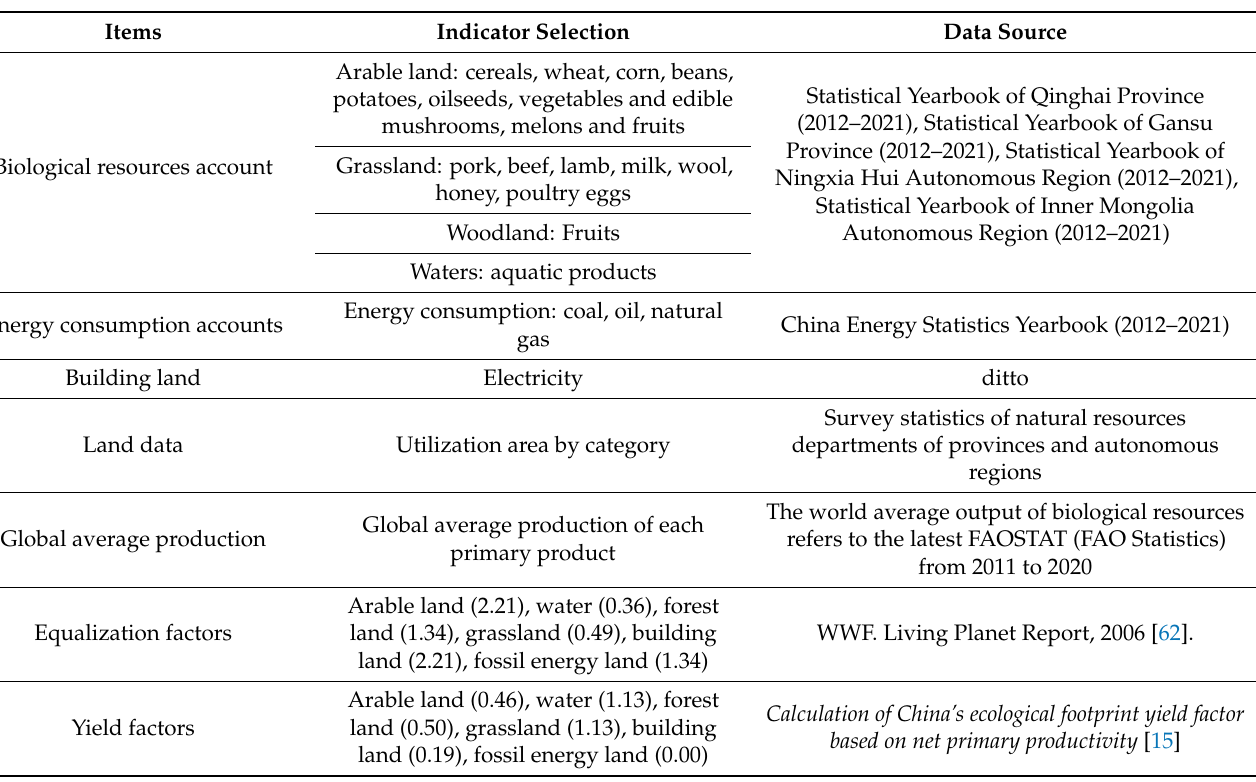
Table 2. Data source and